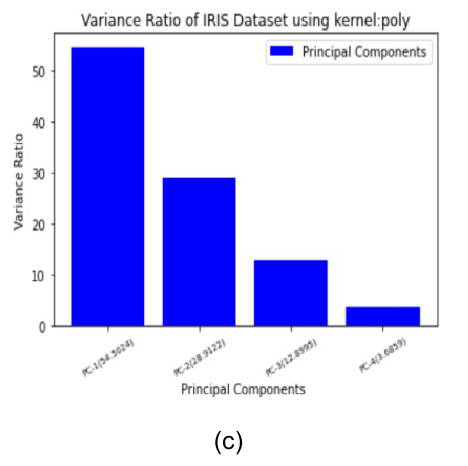
Figure 5. Variance ratio of the existing method (a) kernel: linear (b) KPCA on DIABETES dataset using kernel: linear (c) kernel: RBF.